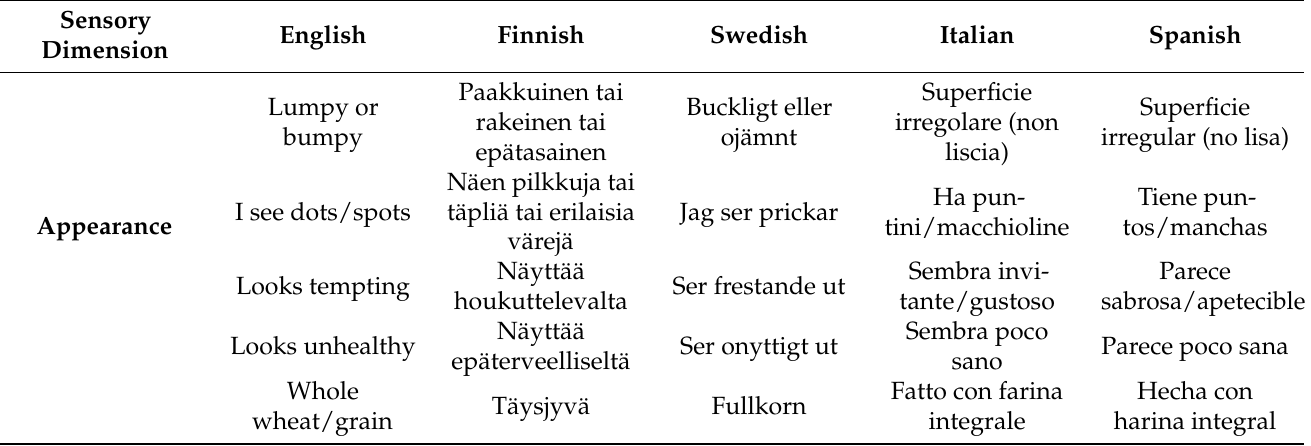
Table 2. Included CATA-terms according to sensory